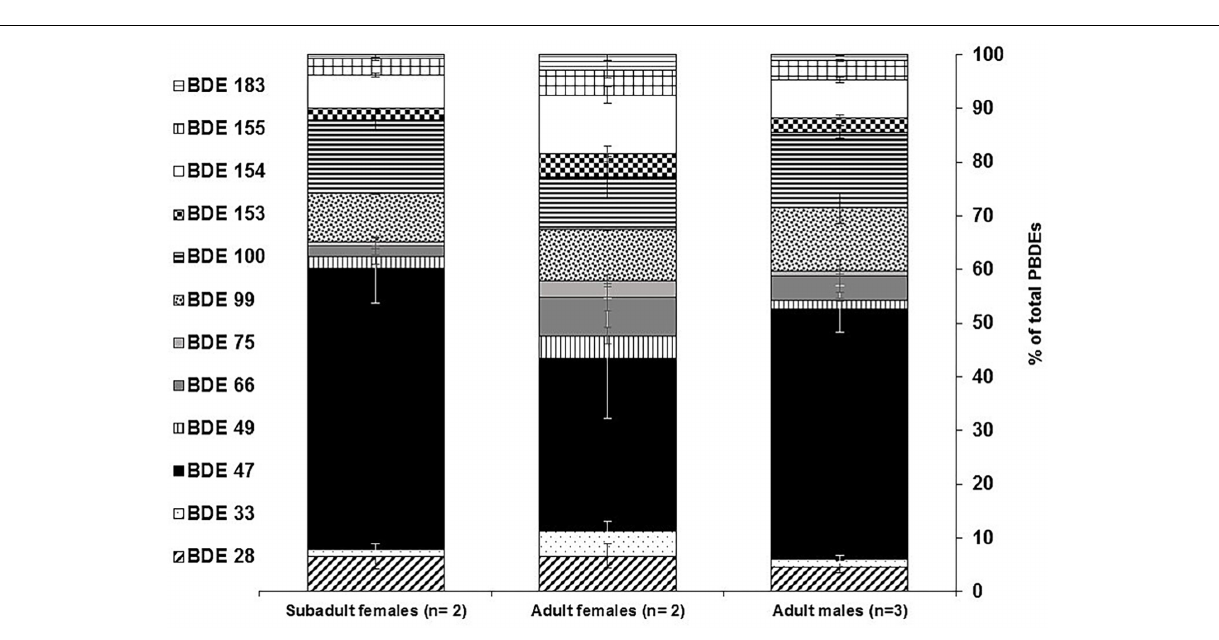
and 3.16 ± 0.64 mg/kg dw (range: 2.43–3.63 mg/kg